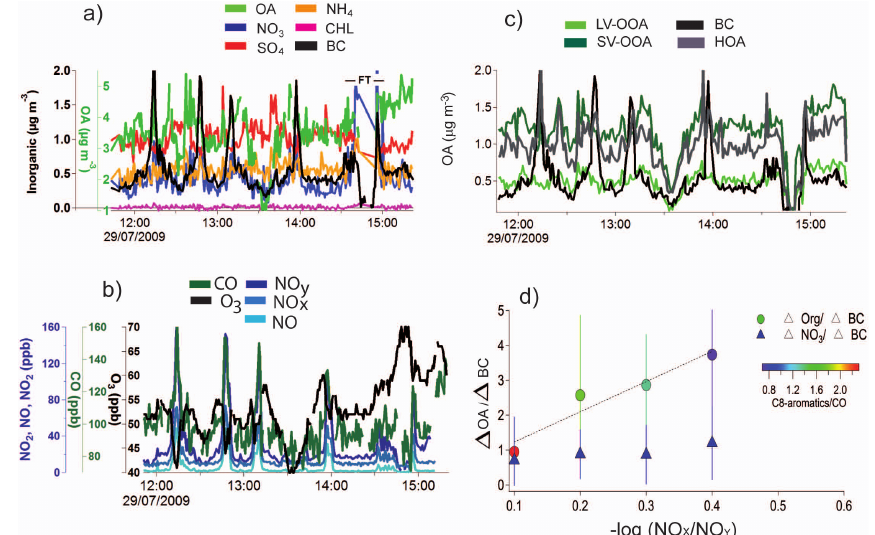
Fig. 2. An overview of aerosol gas and particle composition measured during N29. (a) Time series of AMS particle composition and BC (in black). (b) Time series of gas-phase measurements, (c) PMF analysis of the organic aerosol mass spectra with BC, and (d) increase in the normalized organic aerosol mass concentration as a function of photochemical age. Table 1. Research flight (RF) number, date and principal measurements available during each flight. Total aerosol concentrations inside and outside the urban plume, and percentage of organic contribution and mass concentrations of BC measured within the plume. RF Date Mass concentration OA% BC Flight Flight Plume Background (µg m − 3 ) sector classification 28 13/07/09 3.36 2.69 47 0.54 N N13 29 15/07/09 3.21 2.41 40 0.28 NE NE15 30 16/07/09 5.85 4.37 0.79 N16 31 20/07/09 7.34 6.61 45 0.4 E20 32 21/07/09 10.9 8.8 75 1.04 N21 33 25/07/09 4.18 3.16 35 28/07/09 6.93 4.52 0.62 NE28 36 29/07/09 3.02 2.89 65 0.94